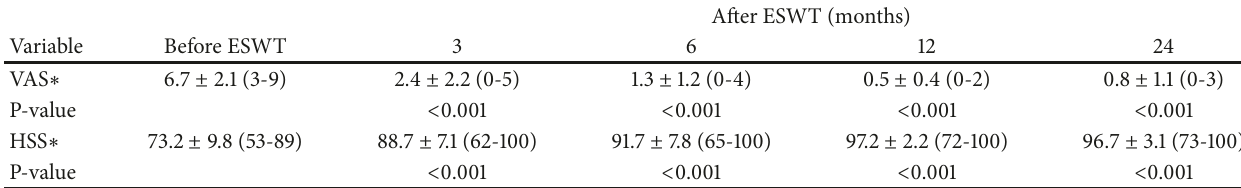
Table 2: The VAS and Harris hip scores before and after ESWT.